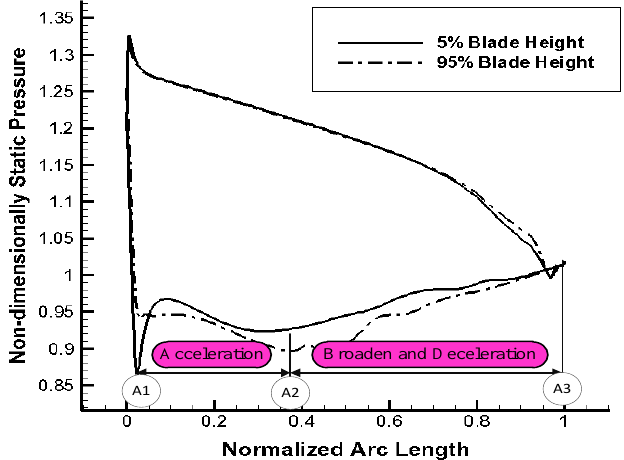
Figure 13. Blade load diagram of the high-reaction tip turbine.